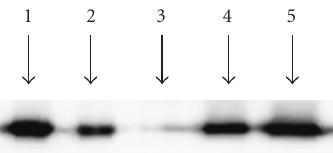
Figure 3: Western blot analysis of detergent-skinned rat cardiac muscle fibers reconstituted with cTnC WT , cTnC L29Q or cTnC G159D . Muscle protein samples were separated on 12.5% SDS-PAGE. Proteins from gel were transferred to a PVDF membrane and RcTnC was probed with an anti-TnC primary antibody (Fitzgerald M5092922). Protein profiles in lanes 1–5 represent the following: lane 1, purified RcTnC; lane 2, fibers reconstituted with c-myc RcTnT + RcTnI + RcTnC-WT; lane 3, fibers reconstituted with c- myc RcTnT + RcTnI; lane 4, fibers reconstituted with c-myc RcTnT + RcTnI + RcTnC-L29Q; lane 5, fibers reconstituted with c-myc RcTnT + RcTnI + RcTnC-G159D.